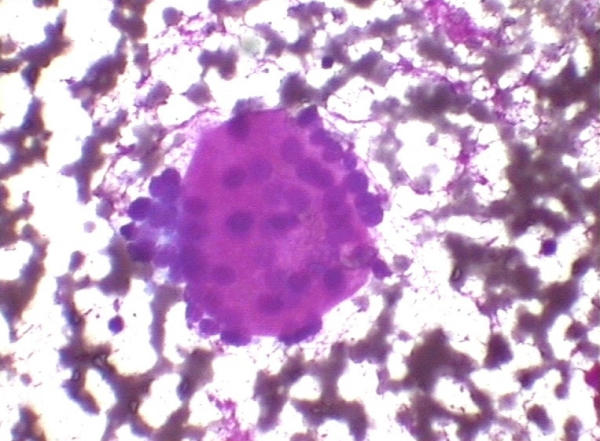
FNAC liver showing metastatic ACC, H & E (× 400)